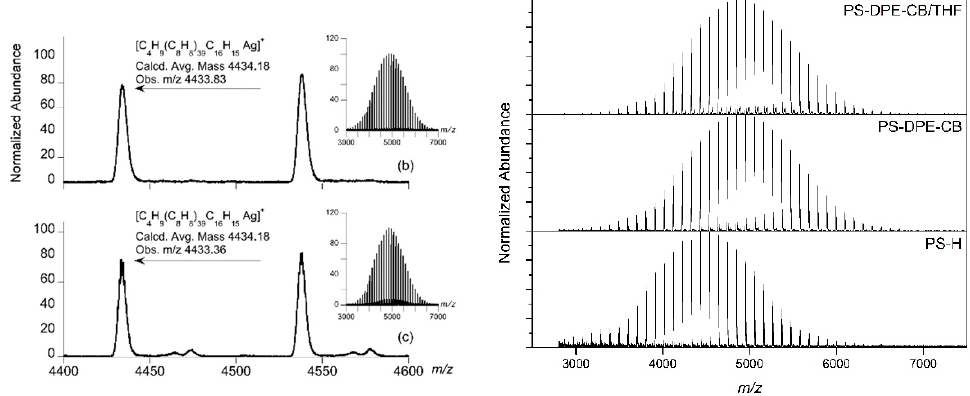
Figure 2. Matrix-assisted laser desorption-ionization mass spectra (MALDI-TOF MS) spectra of the PS-DPE-CB, and the PS-DPE-CB/THF.